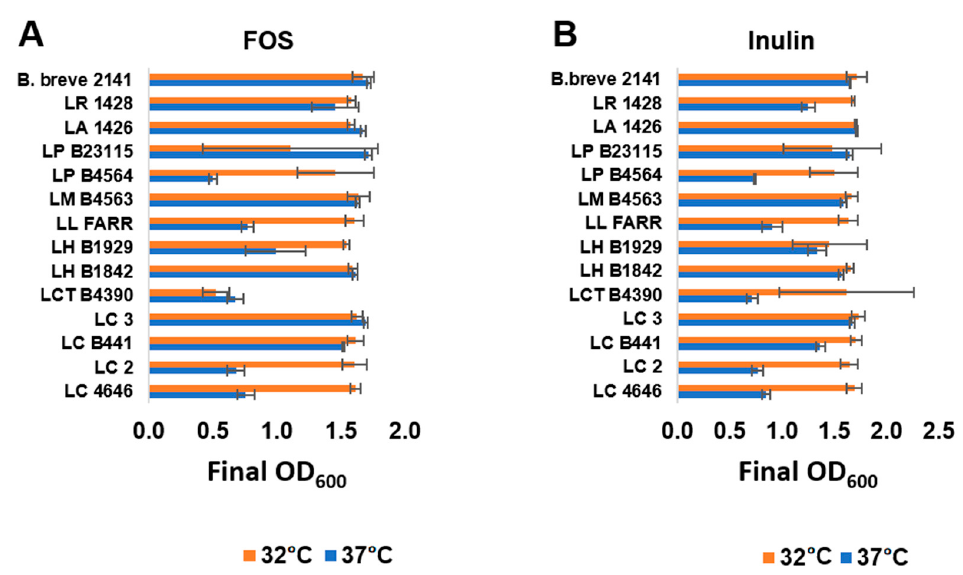
Figure 2. Growth of selected Lactobacillus strain at 32 °C (orange bars) or 37 °C (blue bars) in mMRS broth with ( A ) 1% FOS or ( B ) inulin under anerobic conditions. Bars represent the average optical density (600 nm) after 24 h of growth (± standard deviation).